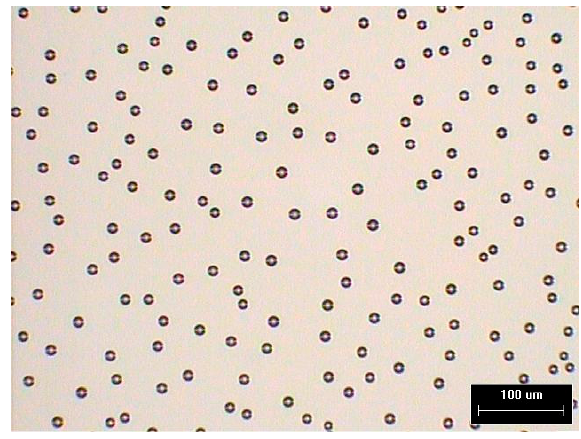
Figure 4. The diameter of droplets on silicon changed with substrate temperature and with the time after reaching the designated temperatures.